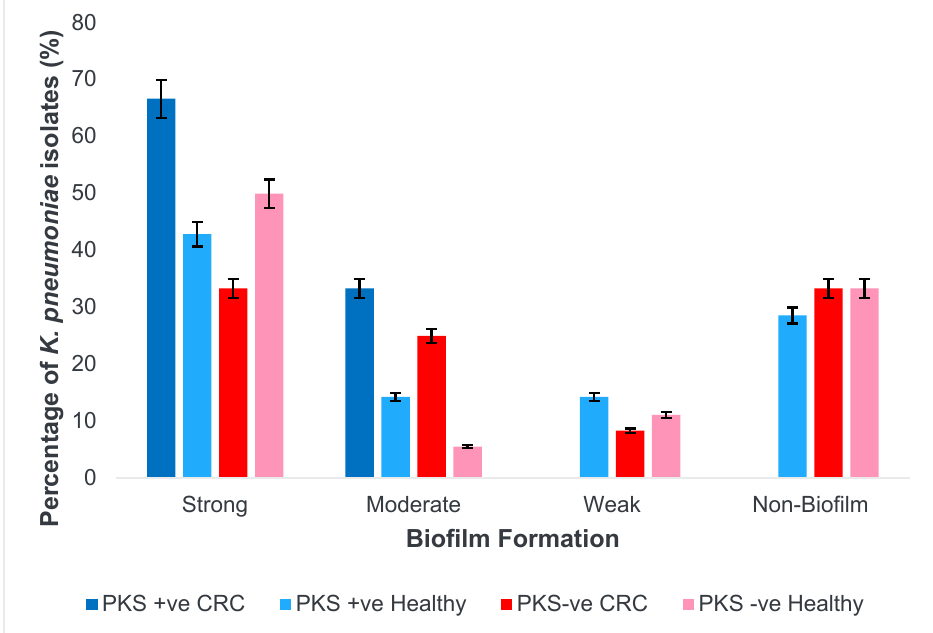
Figure 5: Biofilm forming capabilities of K. pneumoniae isolates.